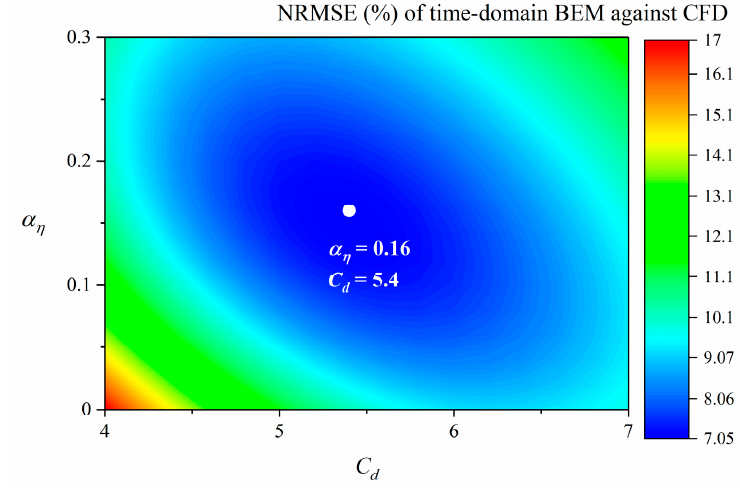
Figure 16. NRMSE of BEM against CFD for different values of 𝛼